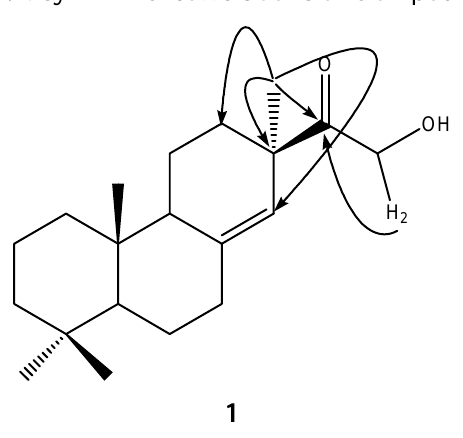
Figure 2. Key HMBC correlations of Compound 1